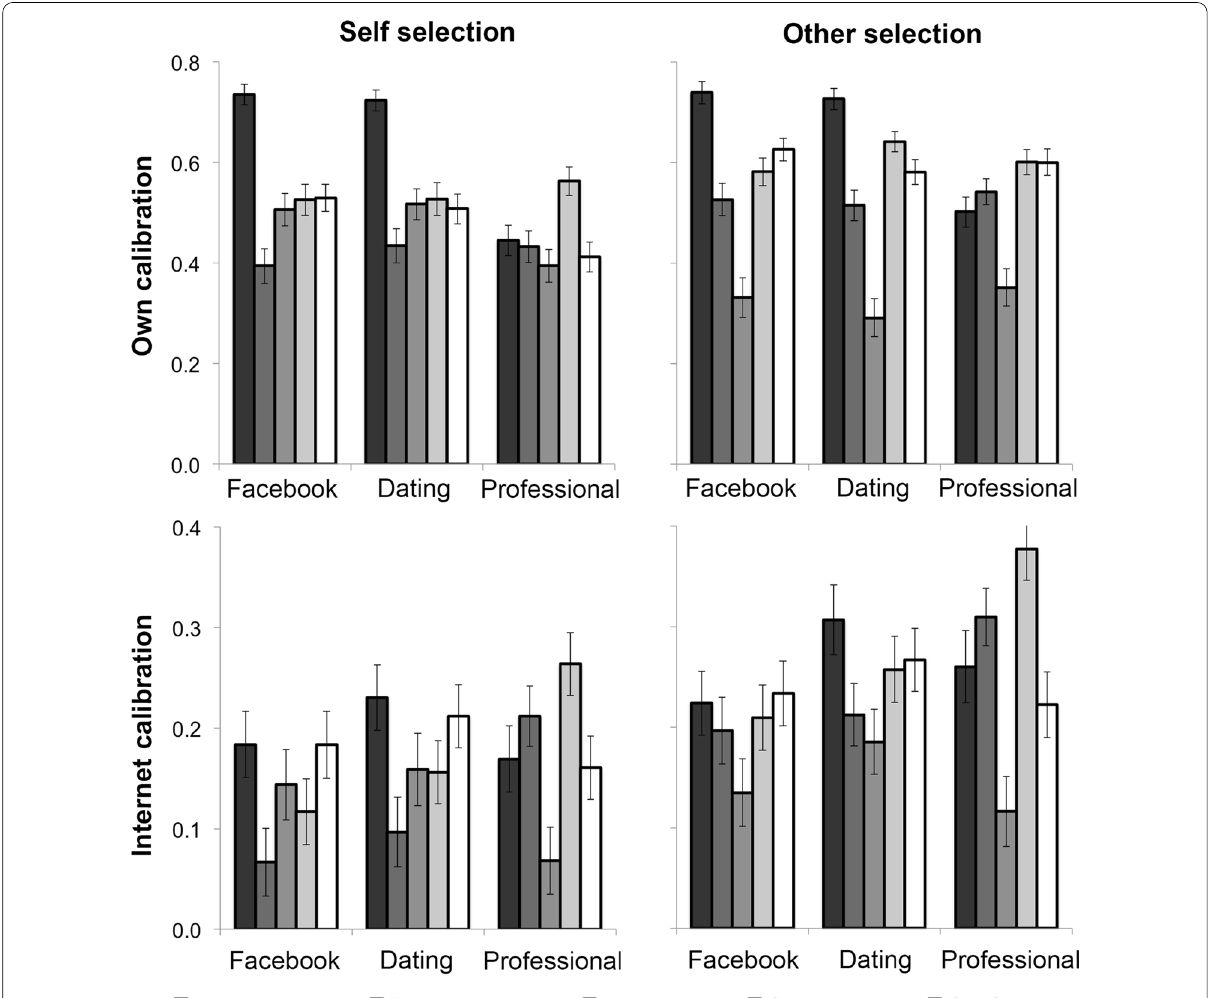
Fig. E1 Corrected results from the Calibration experiment. The data in the upper panels remain unchanged from the original publication, but the data in lower panels has changed subsequent to